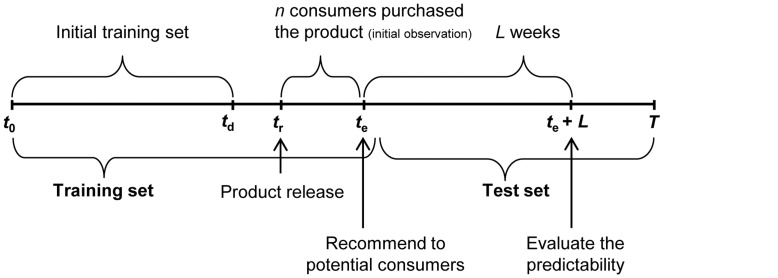
Experimental design.